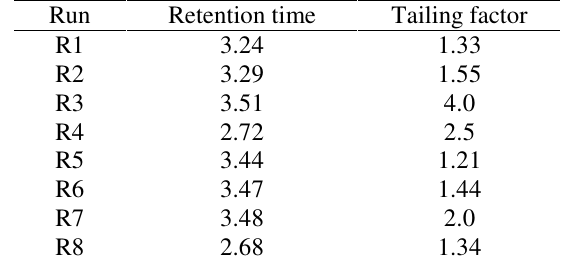
Table 3 . Experimental values for the retention time and the tailing